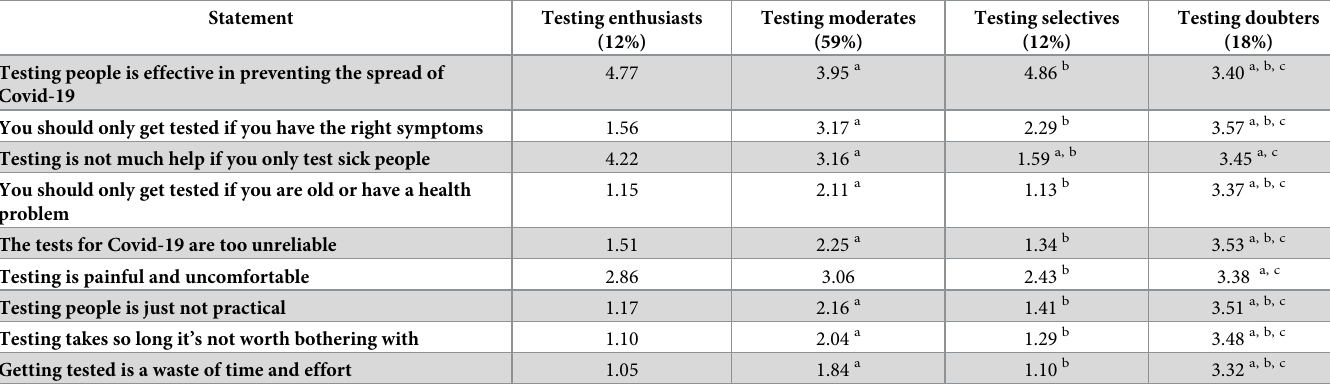
Table 9. Belief segments for Covid-19